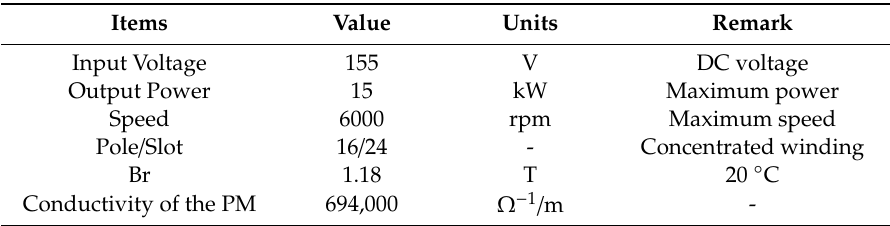
Table 1. Specifications of the analysis